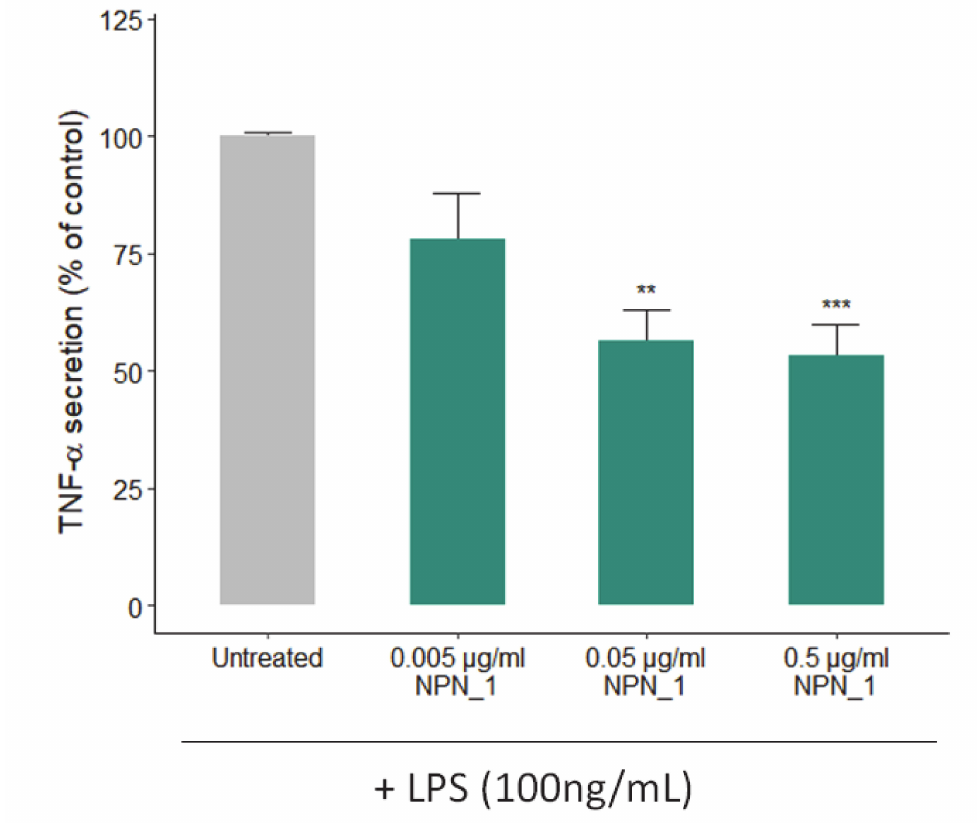
Figure4. E ff ectofNPN_1onTNF- α secretioninTHP-1di ff erentiatedmacrophages. THP-1macrophages were treated with NPN_1 (0.005–0.5 µ g / mL) for 24 h before treating with 100 ng / mL of LPS for 24 h. The secretion of TNF- α was quantified by ELISA (one-way ANOVA analysis; ** p < 0.01; *** p < 0.001; at least three independent